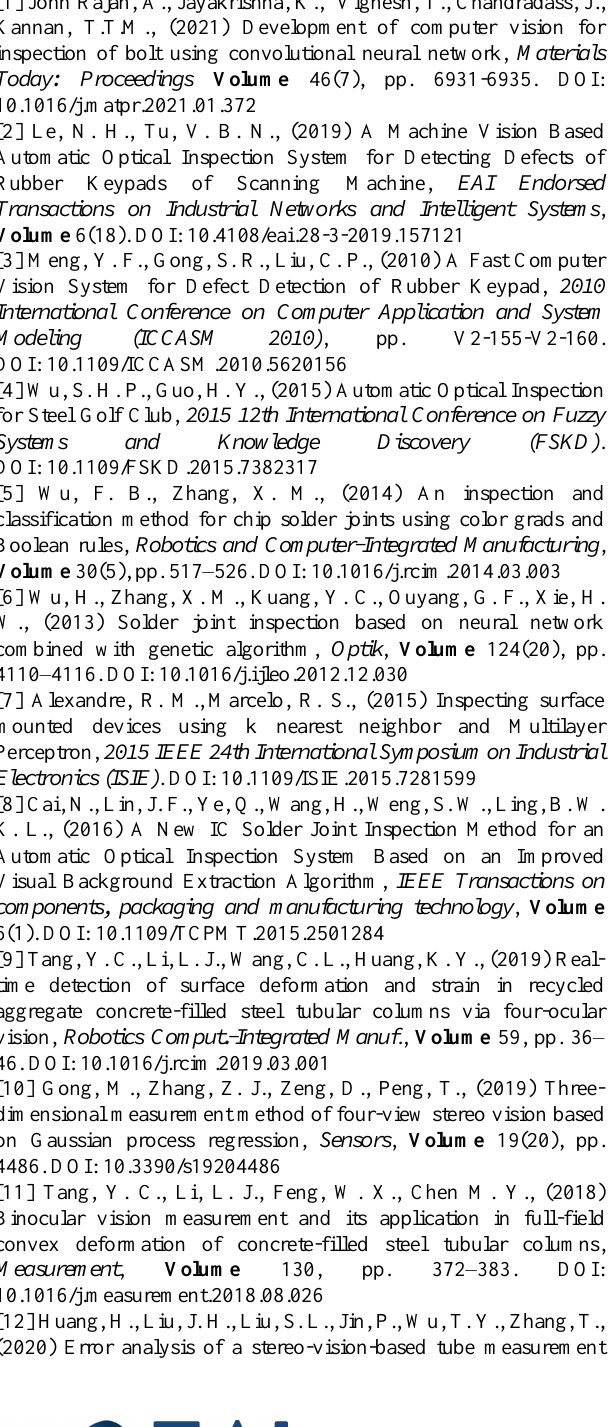
(2020) Error analysis of a stereo-vision-based tube